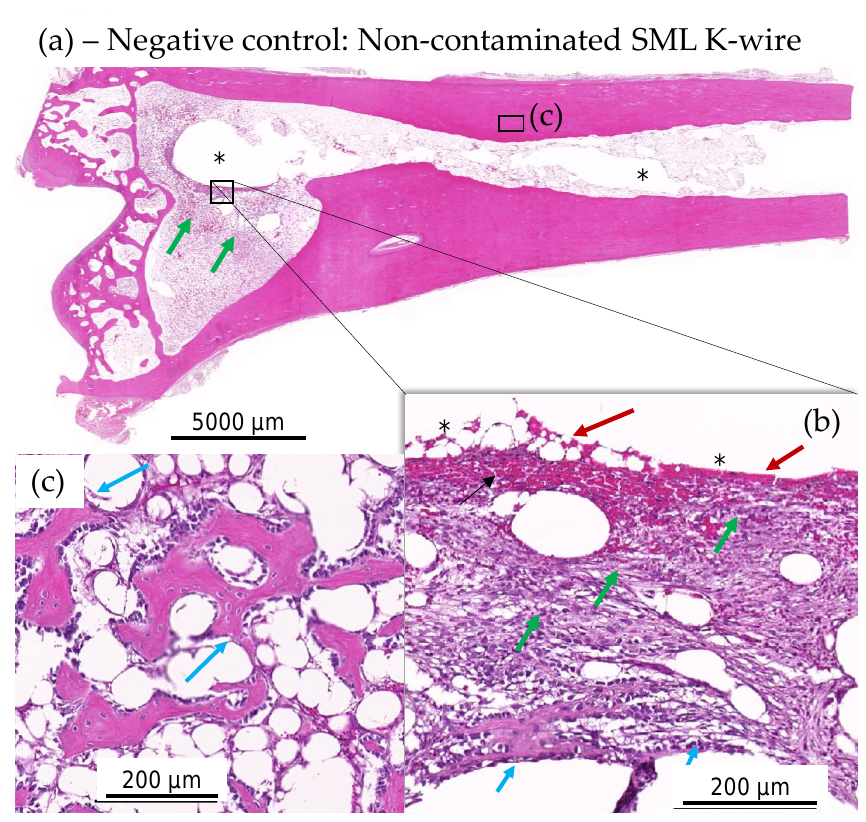
Figure 9. ( a – c ) Histology images of distal tibia of test item animal. No evidence of mild ongoing osteomyelitis along the K-wire in most SML K-wire implanted animal and stabilization was often seen to be more significant in the test item at tip of the K-wire imprint (*). Integration was by means of fibroplasia (green arrows) and new fibrous bone formation at host-implant interface ( b , blue arrows), devoid of any heterophilic infiltration ( c ).